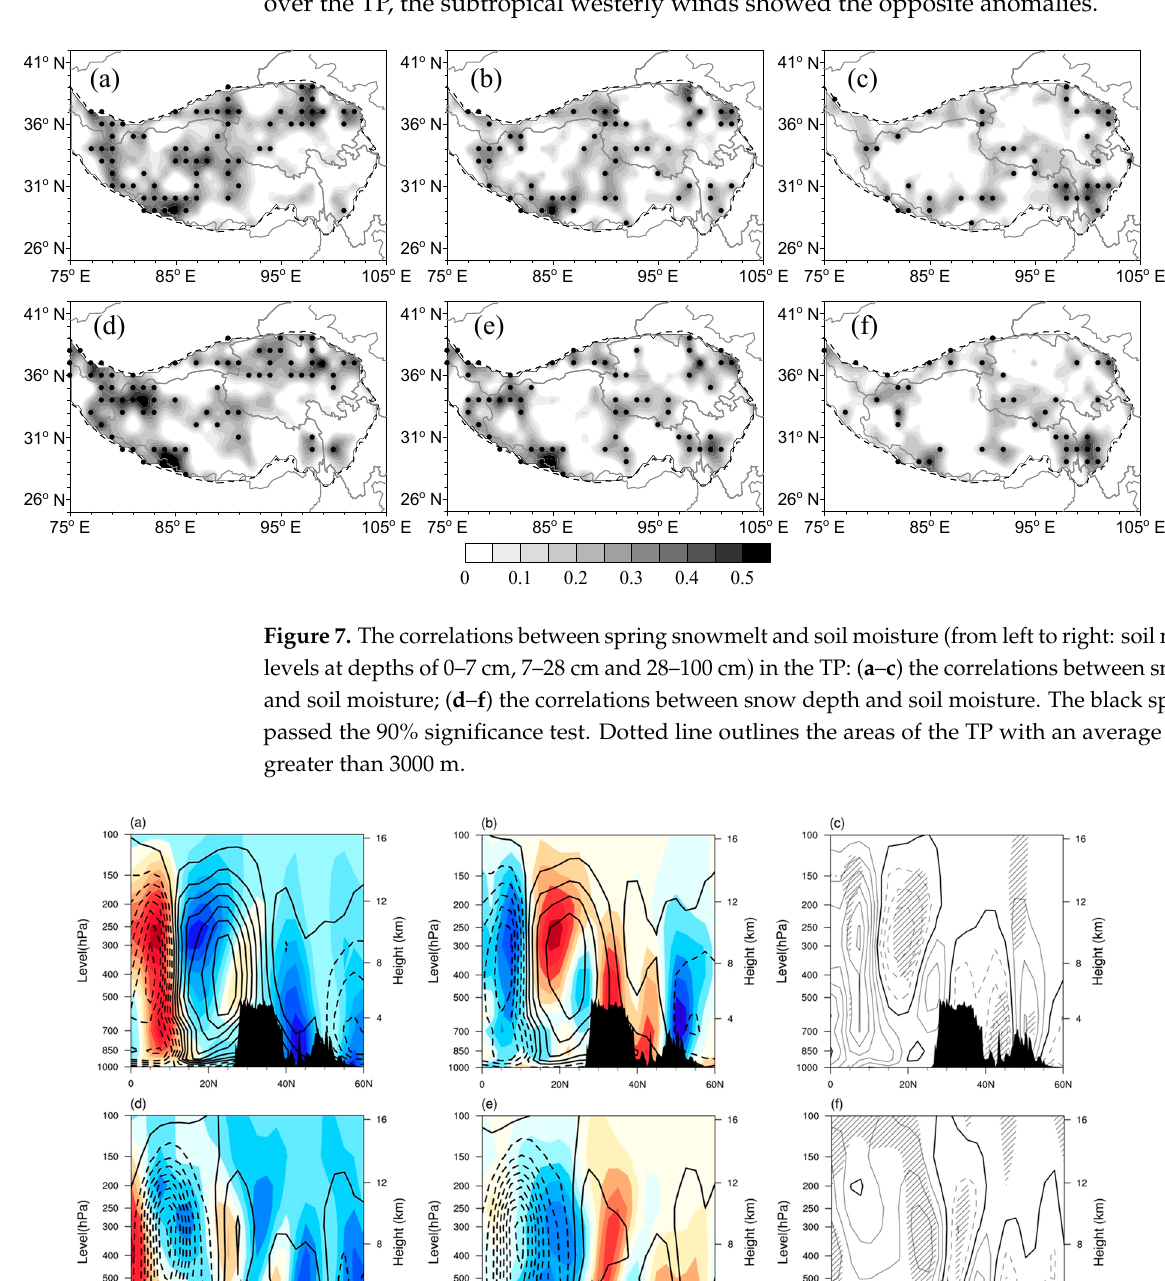
over the TP, the subtropical westerly winds showed the opposite anomalies.